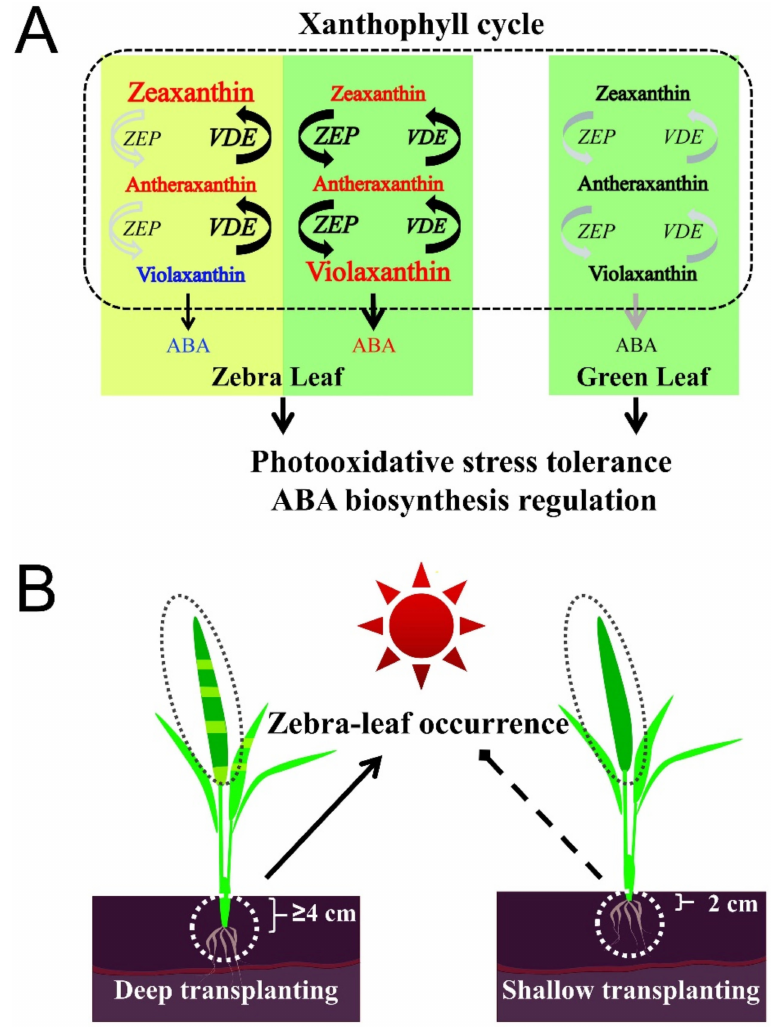
Figure 7. Patterns of zebra leaf occurrence and metabolic regulation. ( A ) Work pattern of xantho- phyll cycle in regulation mechanism in rice zebra leaf. ( B ) Occurrence pattern of zebra leaf in rice. Metabolites downregulated/upregulated in rice leaves are marked in blue/red color according to our results of B03S. Gene expressions of xanthophyll cycle upregulated in leaves are marked with the black and increased font according to data in the